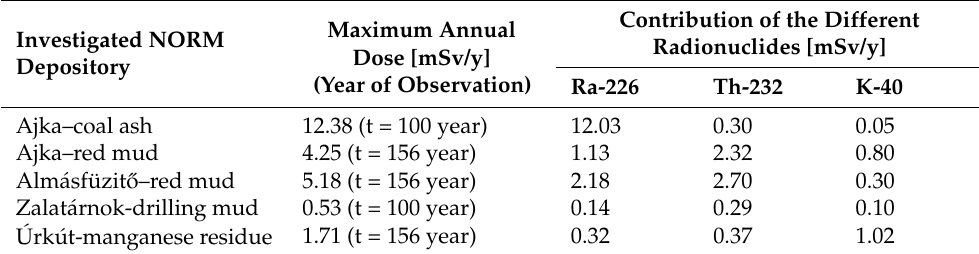
Figure 2. Total annual dose from all radionuclides and all pathways. ( A ) Ajka coal, ( B ) Ajka red mud, ( C ) Almásfüzitő red mud, ( D ) Zalatárnok drilling mud, ( E ) Ú rkút manganese. Table 3. The maximum annual dose value, the observation of the year, and the contribution of Ra-226, Th-232, and K-40 to this